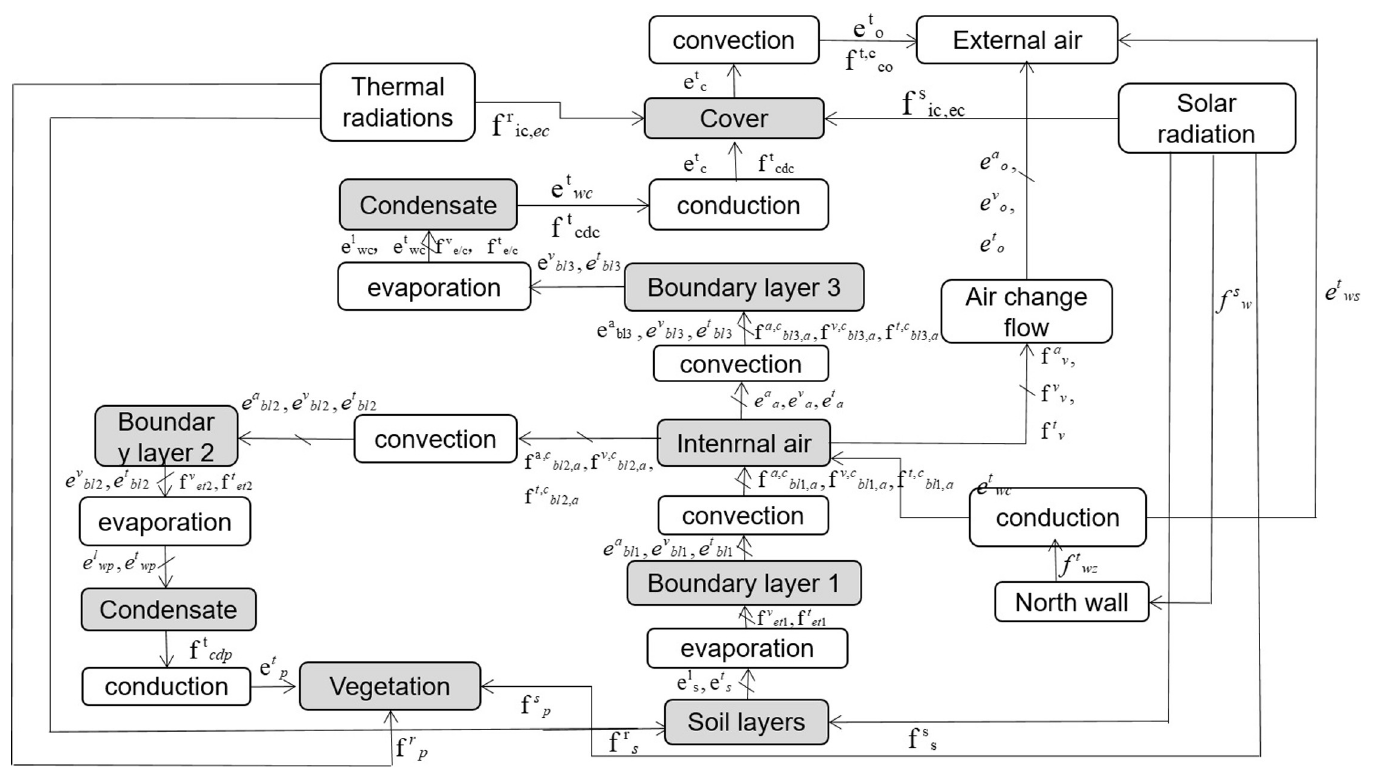
Fig 4. Energy structure of the CSG